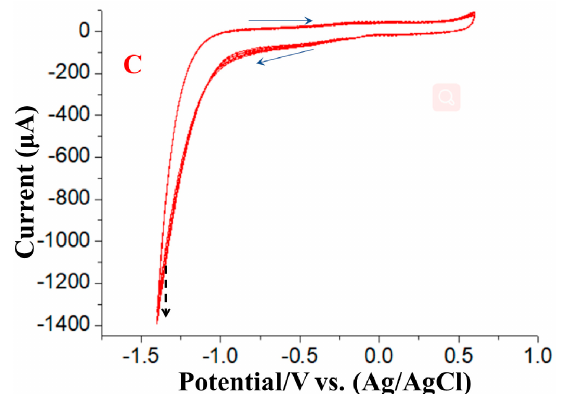
Figure 1. CV curves for the electroanalysis of ( A ) 0.1 mg/mL GO, ( B ) 0.1 mM HAuCl 4 and ( C ) 0.1 mg/mL GO + 0.1 mM HAuCl 4 in pH 9.0 PBS buffer solution at a scan rate of 50 mV/s. The black dash arrow and blue arrow indicate the scan direction and current changes direction, respectively.